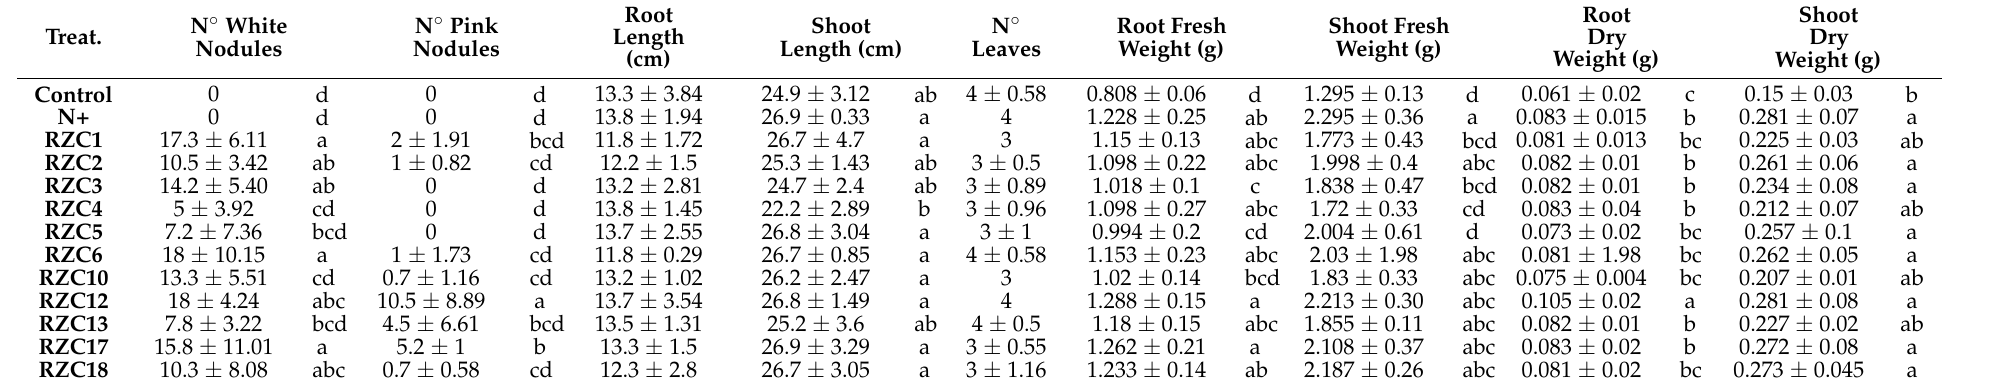
Table 4. Authentication effect of rhizobia strains on red kidney beans.